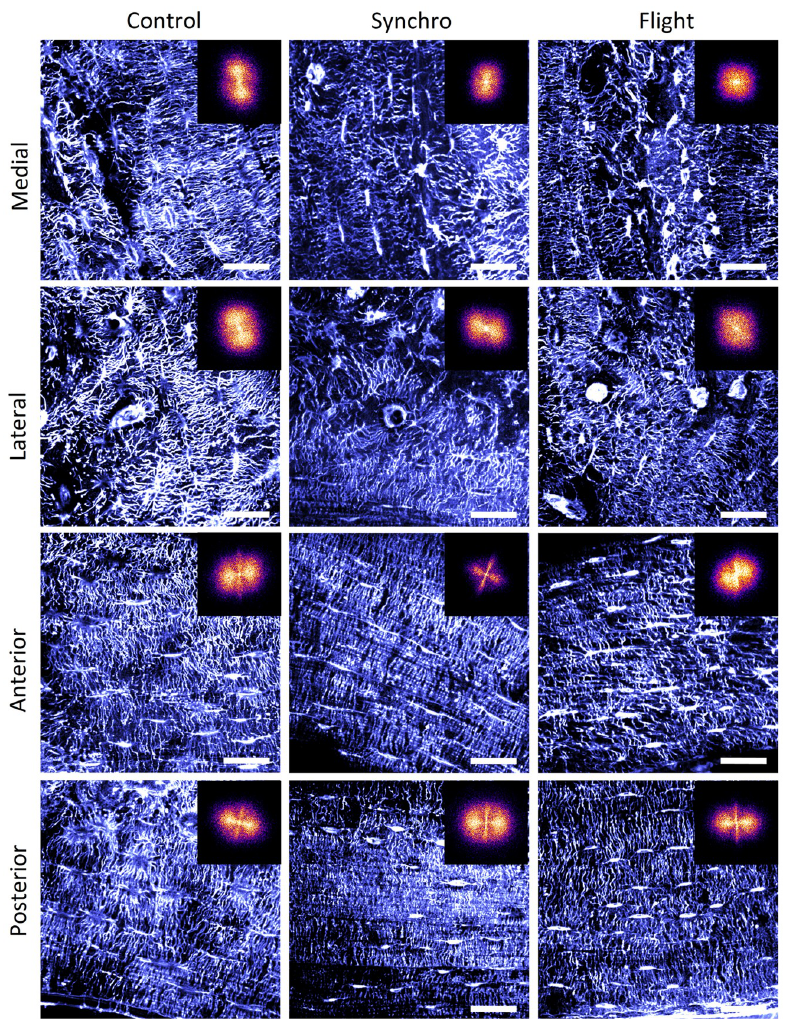
Fig 4. Anatomical variability of the LCN. THG images of the LCN of a sample from the control (left), synchro (center) and flight (right) groups in the M, L, A and P regions (from top to bottom). The inset shows the module of the Fourier-transformed images after vesseleness filtering.Scale bar 30 μm